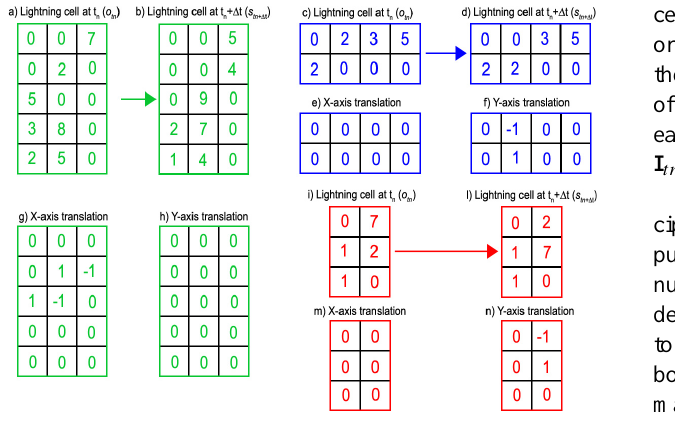
Fig. 4. Example of pixel scrambling for three lightning cell: 8- connected cells O tn of O tn at time t = t n (panels a , c and i ), relative matrices s tn + 1t of O tn + 1t at time t = t n + 1 t (panels b , d and l ), and corresponding X tn and Y tn translation in the cross-track and along-track direction, respectively (panels e–f , g–h and m–n ). Defining s t 0 n + 1t the sub-matrix of O t 0 n + 1t